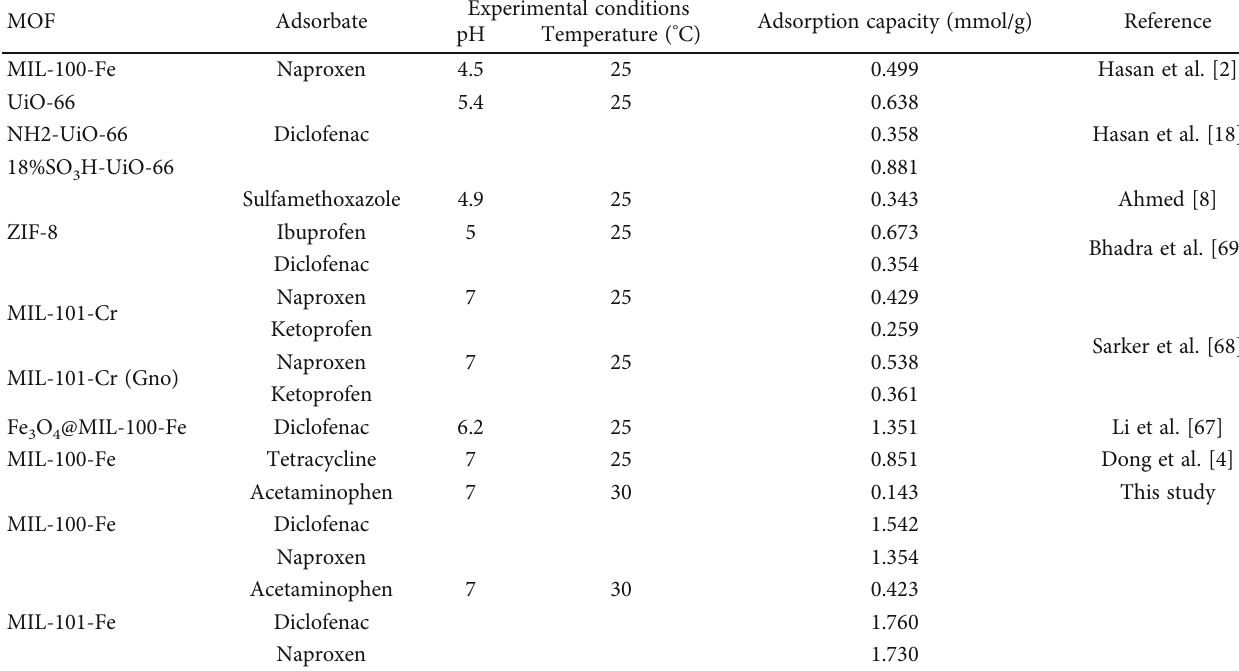
Figure 5: Isotherms of the adsorption of the adsorption of acetaminophen, diclofenac, and naproxen on MIL-100-Fe and MIL-101-Fe from aqueous solution at pH 7. Table 3: Adsorption capacities for di ff erent pharmaceuticals using MOFs as